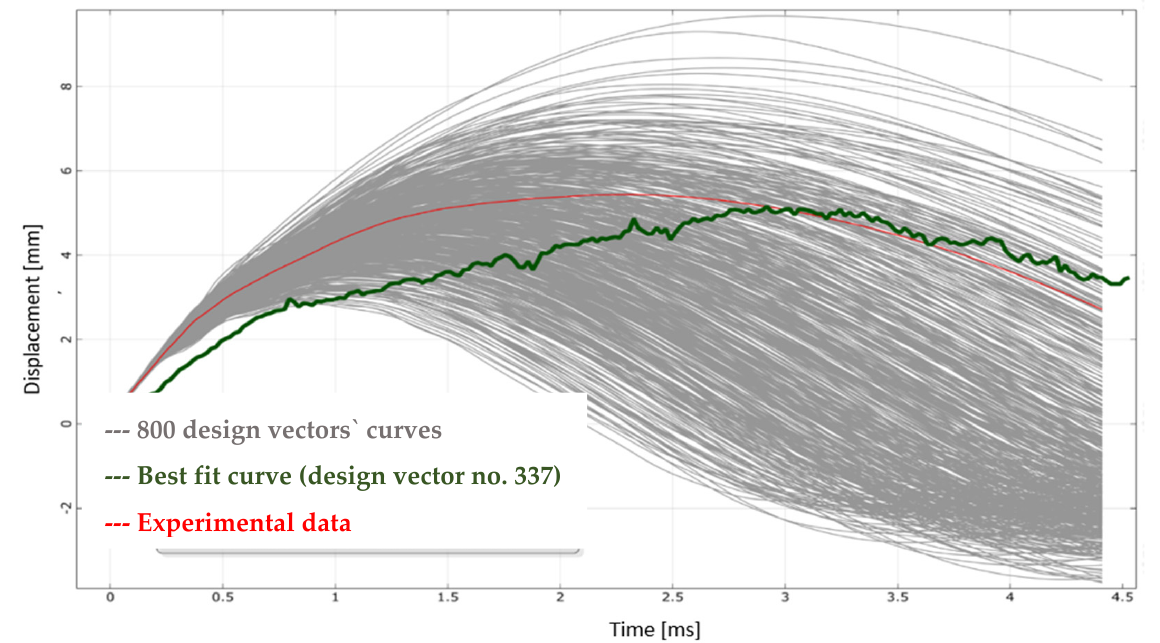
Figure 9. Comparison of the deflection curves obtained by simulation (red and grey) with the experimentally obtained curve (green colour). Table 10. Resulting design values of concrete